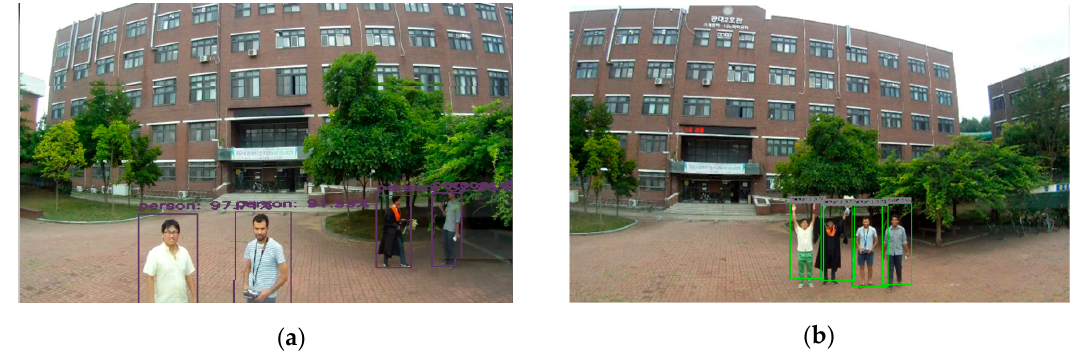
Figure 16. Target detection results from the drone of ( a ) YOLO tiny using Odroid XU4 + NCS and ( b ) SSD-MobileNet using Odroid XU4 + NCS.